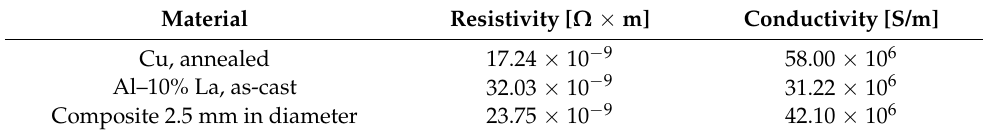
Table 2. Results of measuring the electrical resistance of the composite samples. Material